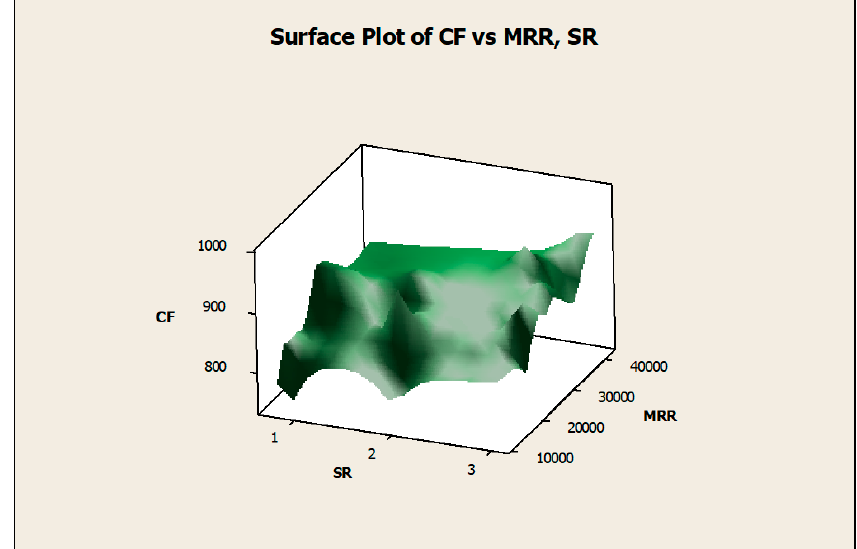
Figure 15. Surface diagram of CF with respect to MRR and SR.